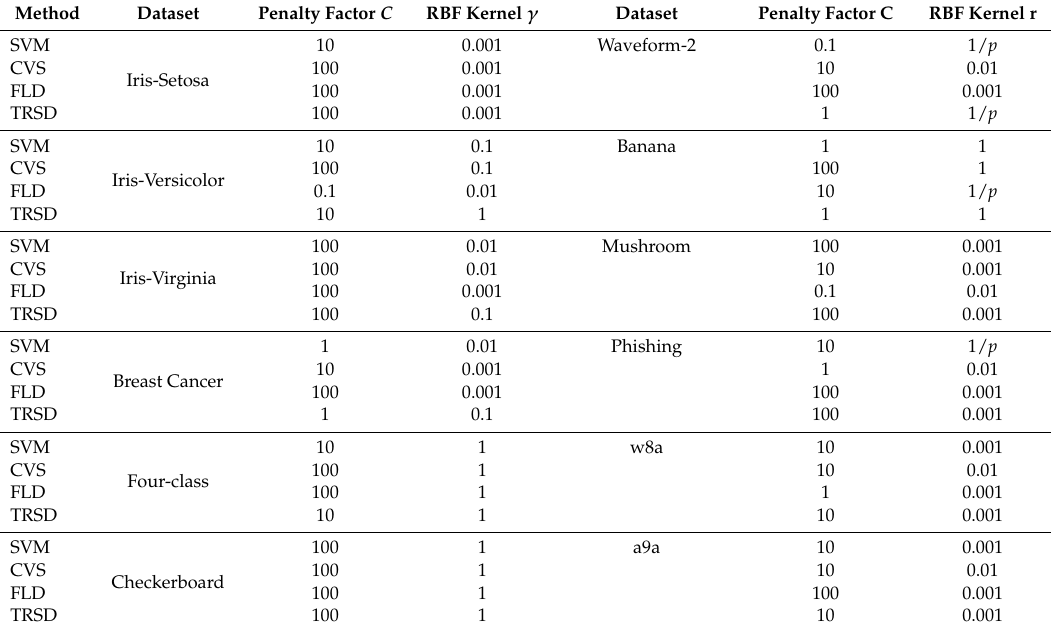
Table 3. Hyper-parameters setting for the